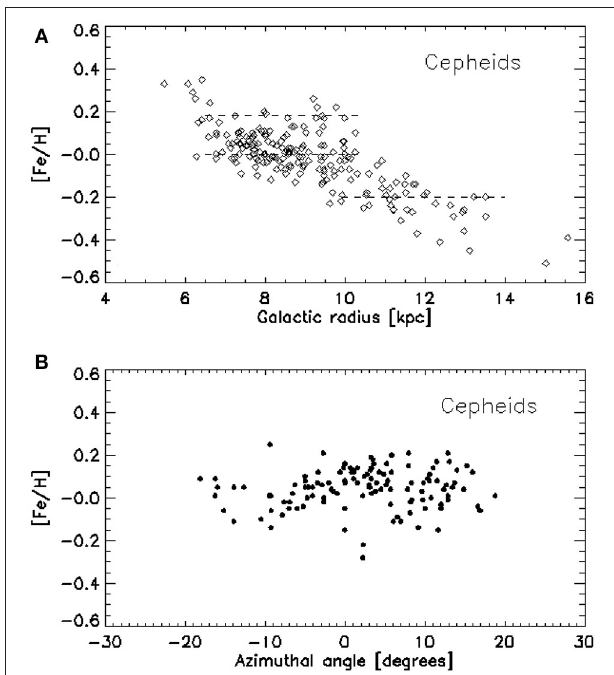
FIGURE 6 | (A) The iron abundance of Cepheids, normalized to the solar abundance (0, in log scale), as a function of Galactic radius. The data are taken from different authors (see Lépine et al., 2011b). The Galactocentric distances have been re-calculated using R 0 = 8.0kpc. The gap in the distribution of Cepheids in the Cassini-like gap can be noticed. The metallicity gradient is zero between 6.5 and 10kpc, although, apparently, there are groups of stars with distinct metallicities (dashed lines). There are many Fe–rich stars in the 8–10kpc range. The Cassini gap is a barrier for the gas, but not for the stars. There is no contact between the gas of the inner and outer regions. The gas metallicity enrichment was slower in the outer part, due to lower star formation rate, and consequently, the Cepheids born in that region show smaller metallicities. Possibly, a number of Cepheids born in the Fe–rich region migrated to the Fe–poor one, producing some overlap of Cepheids of different origin. (B) The iron abundance of Cepheids as a function of Galactocentric azimuthal angle (90 ◦ − ϕ ). Angle 0 is the Galactic center–Sun direction, positive angles are in the direction of Galactic rotation. Only the stars situated in the Galactic radius range 7.5 to 10kpc are represented. There is a growing Fe abundance from azimuthal angles − 10 ◦ to + 5 ◦ , of about 0.2dex, and then a broad maximum. Adapted from Lépine et al.